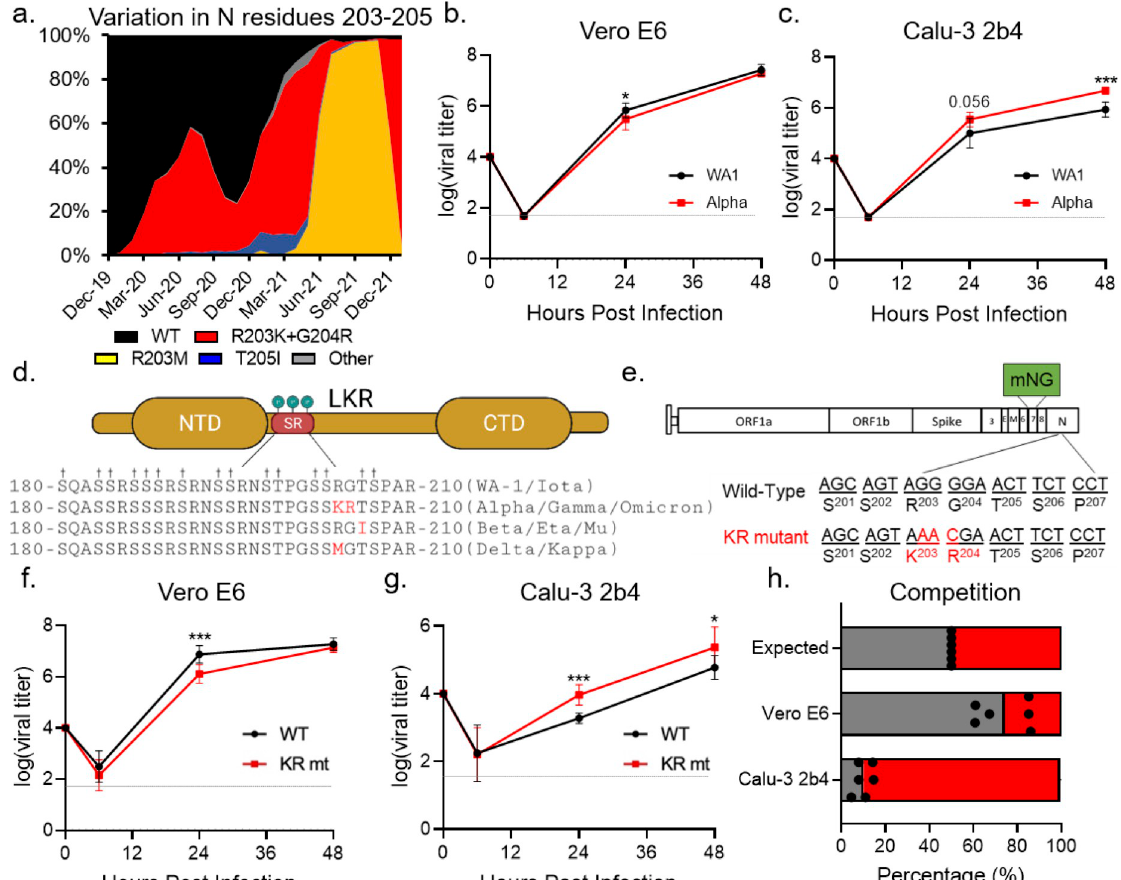
Fig 1. The KR mt enhances SARS-CoV-2 replication. ( A ) Amino acid frequencies for nucleocapsid residues 203–205 in SARS-CoV-2 sequences reported to the GISAID, binned by month of collection and graphed as percent of total sequences reported during that period. ( B-C ) Viral titer from Vero E6 (B) or Calu-3 2b4 cells (C) infected with WA-1 (black) or the alpha variant (red) at an MOI of 0.01 (n � 6). ( D ). Schematic of the SR domain of SARS-CoV-2 nucleocapsid. Variable residues are displayed as red text within the sequence of their corresponding lineages. Phosphorylated residues are indicated by a †. ( E ) Schematic of the SARS-CoV-2 genome, showing the creation of the KR mutation and the replacement of ORF7 with the mNG reporter protein. ( F-G ) Viral titer of Vero E6 (F) or Calu-3 2b4 (G) cells infected with WT (black) or the KR mt (red) at a MOI of 0.01 (n = 9). ( H ) Competition assay between WT (gray) and KR mt (red) in Vero E6 or Calu-3 2b4 cells infected at a 1:1 input ratio with an MOI of 0.01 (n = 6). Titer data are the mean ± s.d. For competition, individual replicates are graphed as points, while the mean percentage of each virus is displayed as a bar graph. Statistical significance was determined by two-tailed student’s T-test with p � 0.05 ( � ), p � 0.01 ( �� ), and p � 0.001 ( ��� ). Grey dotted lines are equal to LOD. Schematic in (D) generated using